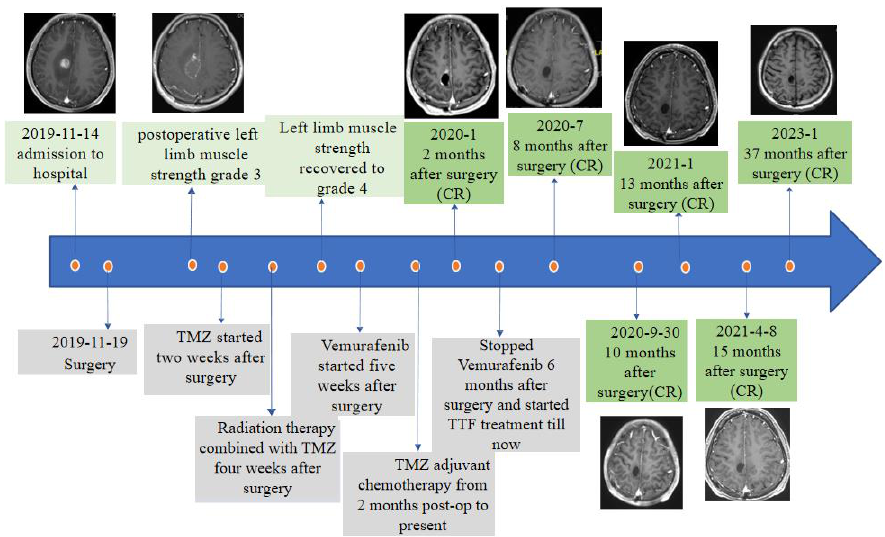
Figure 5. A timeline with relevant data from the episode of care.